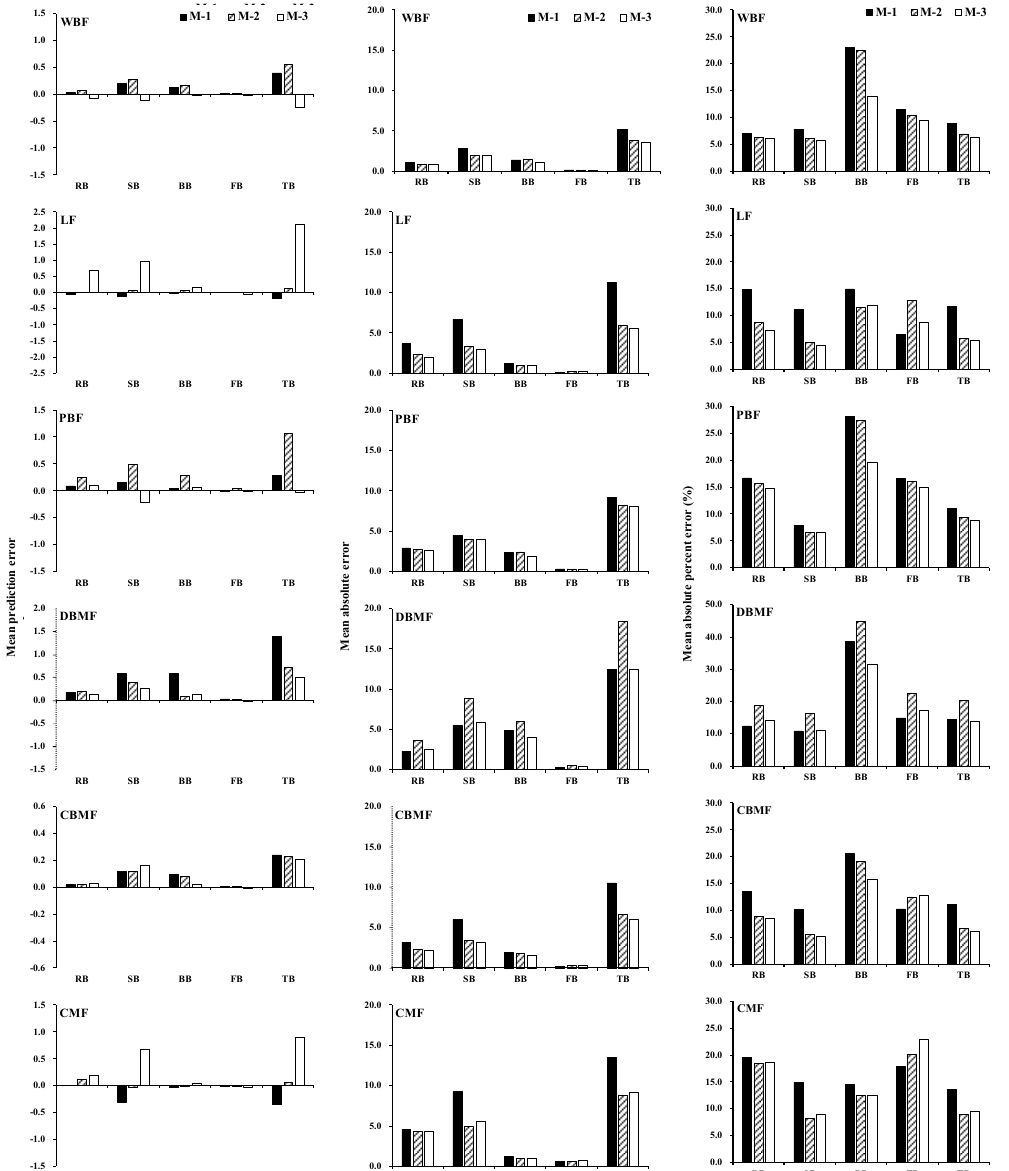
Figure 2. Mean prediction error (MPE), mean absolute error (MAE) and mean absolute percent error (MAE%) among the total and component biomasses for each forest type. WBF, LF, PBF, DBMF, CBMF and CMF stand for white birch forest, larch forest, poplar-birch forest, deciduous broadleaf mixed forest, coniferous and broadleaf mixed forest and coniferous mixed forest, respectively. TB, RB, SB, BB and FB represent the total, root, stem, branch, and foliage biomass,